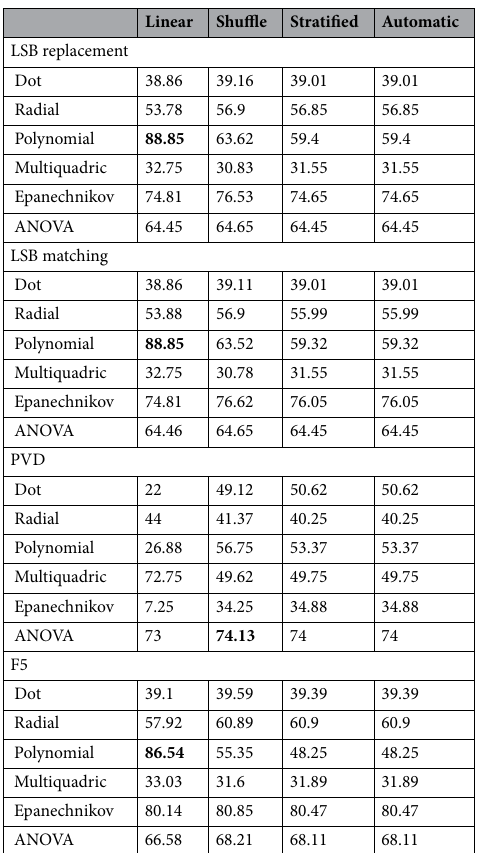
Graph 6. Result of classification of calibrated images with cross-validation using SVM for random %. Linear Shuffle Stratified